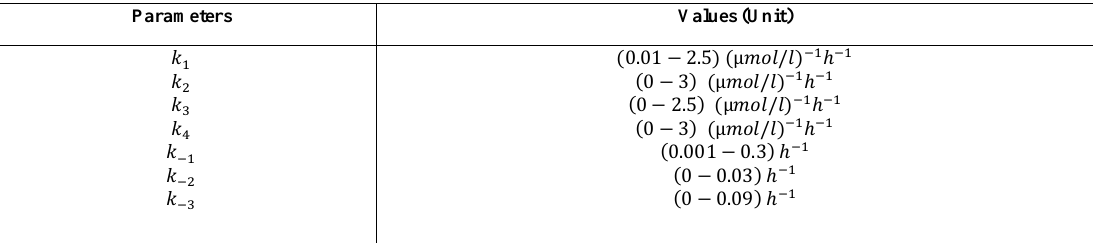
Table 1. Values of the parameters used in numerical